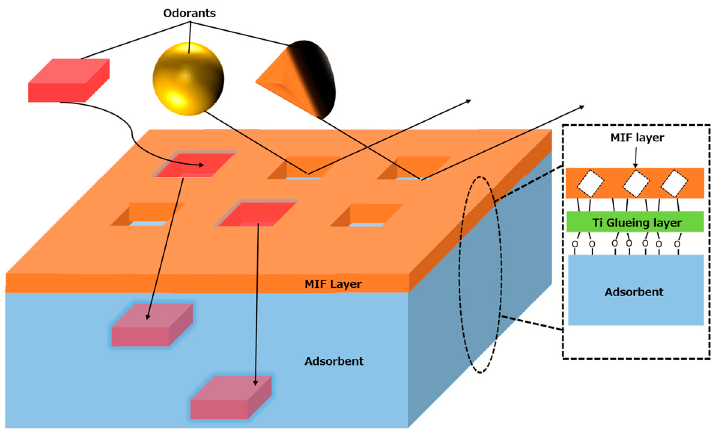
Figure 2. Structure of a MIFA.